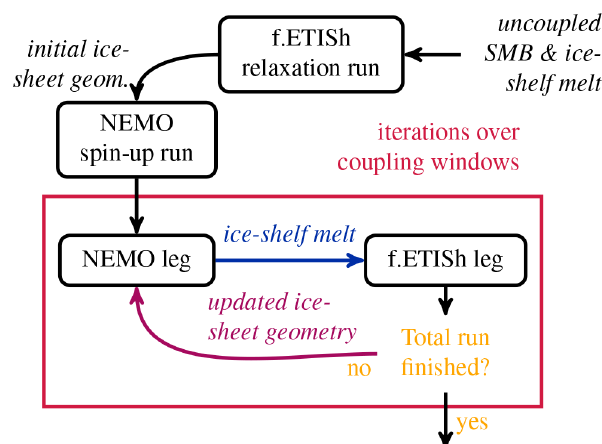
Figure 3. NEMO–f.ETISh coupling procedure. The box represents the coupling loop (one iteration per NEMO–f.ETISh coupling win- dow). Colored arrows represent the data exchange between NEMO and f.ETISh. The NEMO spinup run is used as initial conditions for the first NEMO leg